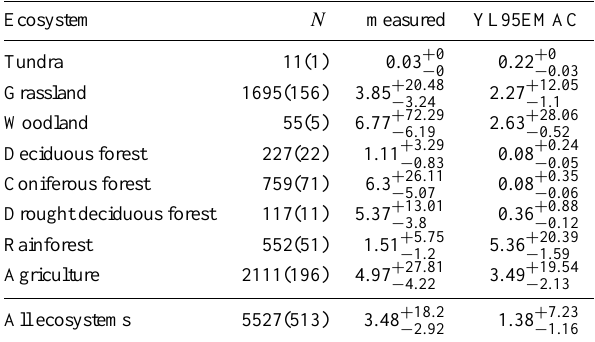
Table 3. The original (YL95) emission factors and the soil biogenic NO emissions calculated with the old ecosystems (YL95EMAC) and with the new landcover (LC). When not shown, standard devi- ations are less than or equal to